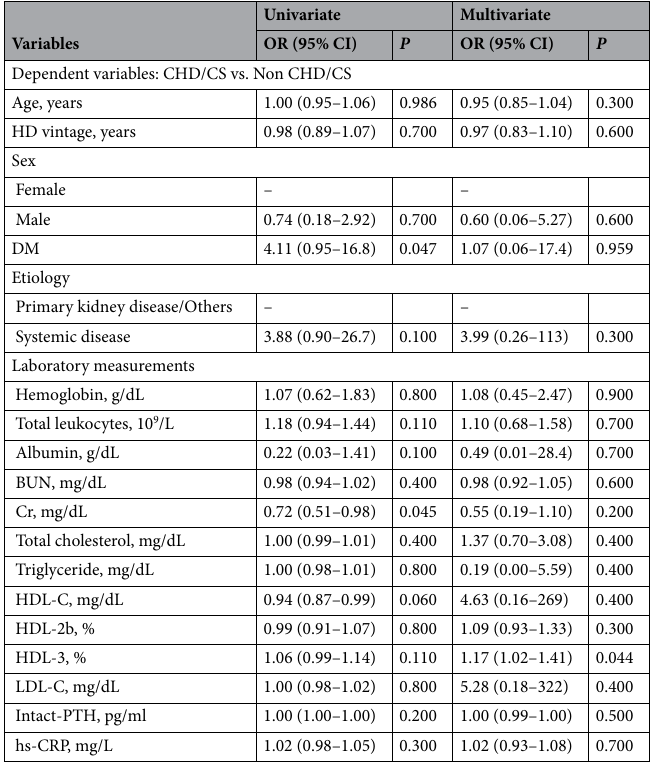
Table 3. Logistic regression analysis for CHD/CS.